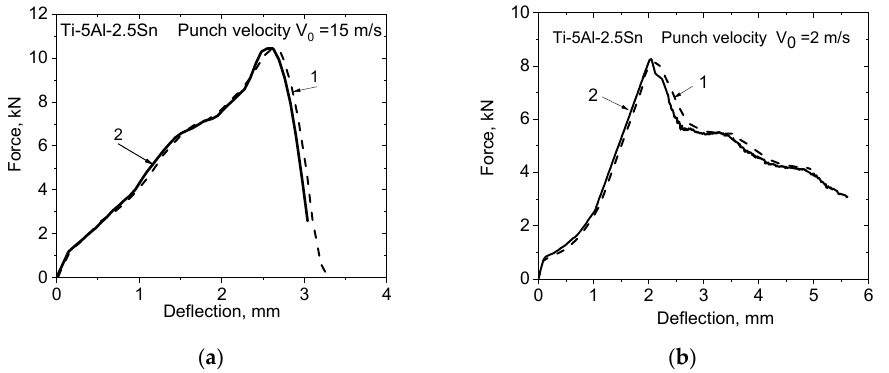
Figure 6. ( a ) Diagrams F( u z ) for Ti-5Al-2.5Sn at an indenter speed of 15 m/s; ( b ) Diagram F( u z ) at a stamp speed of 2 m/s. Curves 1 were obtained by numerical simulation, curves 2 were obtained experimentally.